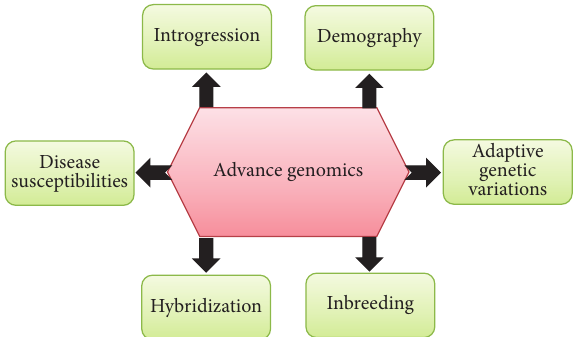
Figure 2: Illustration of advance genomic approaches for the conservation of